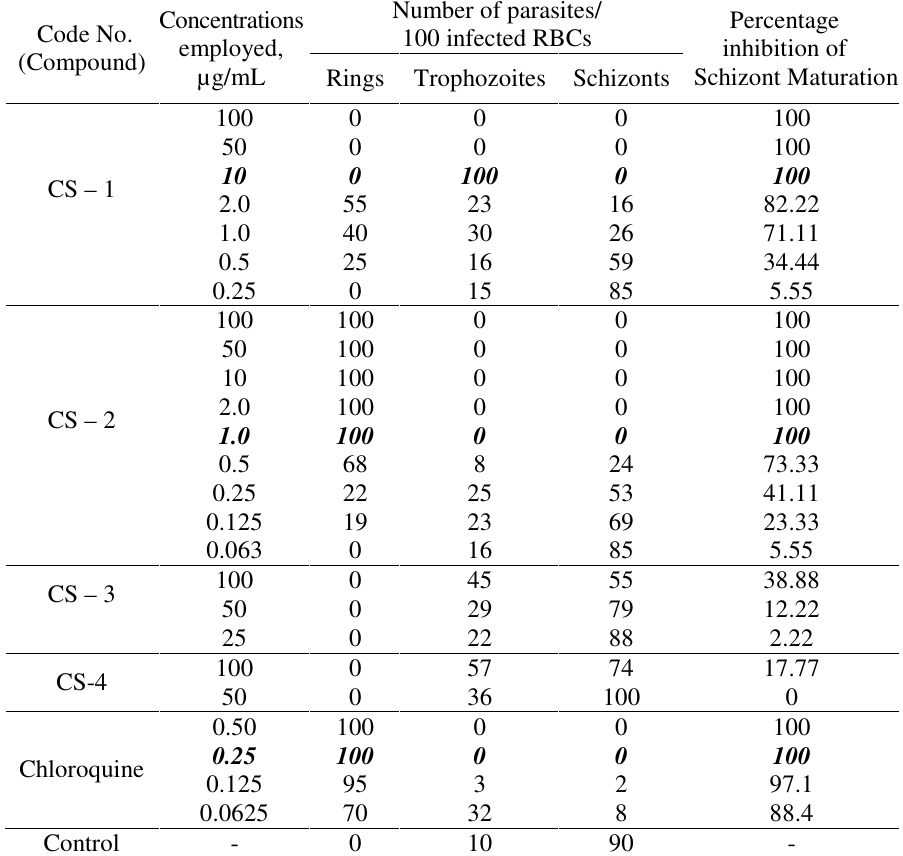
Table 2. In vitro antimalarial activity of synthesized compounds against chloroquine sensitive RKL-2 strain of Plasmodium